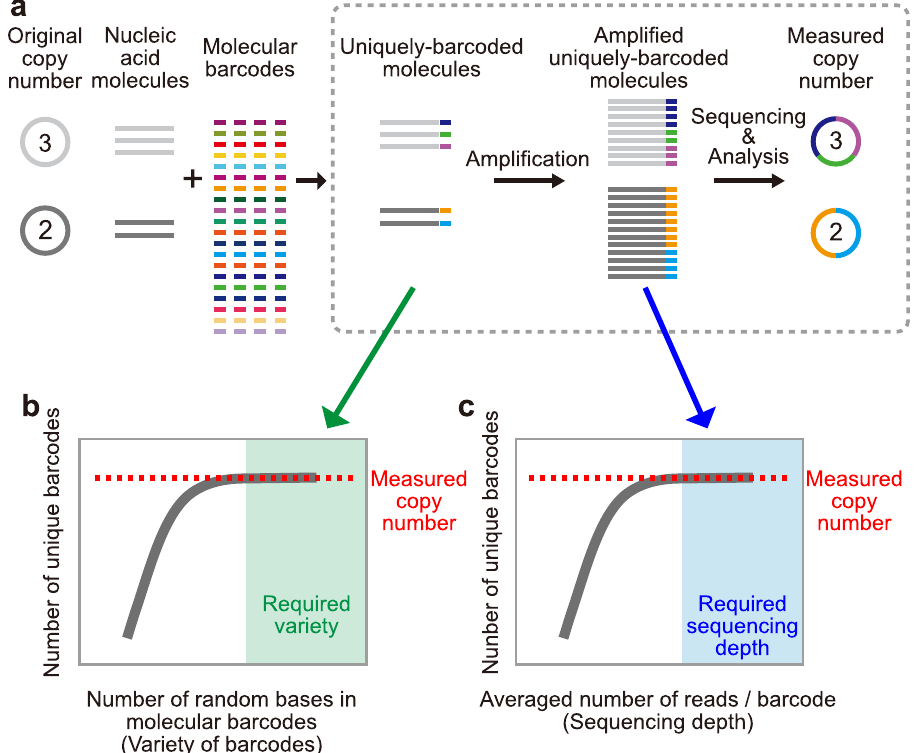
Figure 1. Digital quantification of nucleic acid molecules and its efficacy. ( a ) Scheme of digital counting. A molecular barcode is attached uniquely to each target molecule. After amplification, both the target section and the barcode section are sequenced. The copy number is determined by the number of unique barcodes instead of the number of reads. Dotted frame; experimental design in this study. ( b ) The first requirement for accurate digital counting: each target molecule should be labeled by different barcodes. If the measured number of unique barcodes is constant as the variety of barcode sequences increases, that range of the variety of barcode sequences fulfills the first requirement. ( c ) The second requirement for accurate digital counting: all barcodes attached to the target molecules should be detected (at least one read). If the measured number of unique barcodes is constant as the sequencing depth increases, that range of sequencing depths fulfill the second